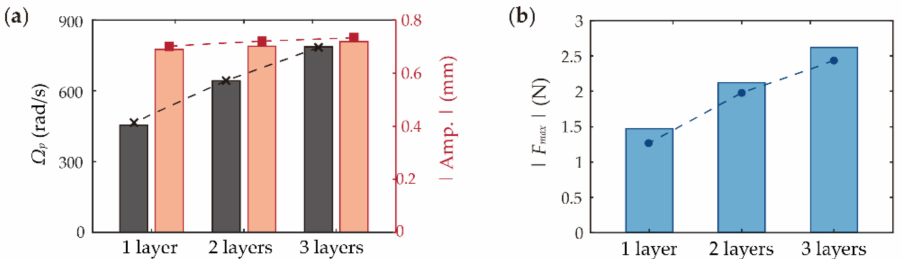
Figure 10. Experimental and modelling results on the effects of number of DEA layers on ( a ) peak frequency and oscillation amplitude and ( b ) peak impact force. The solid bars are the experimental data and the dashed lines with markers are the modelling results.